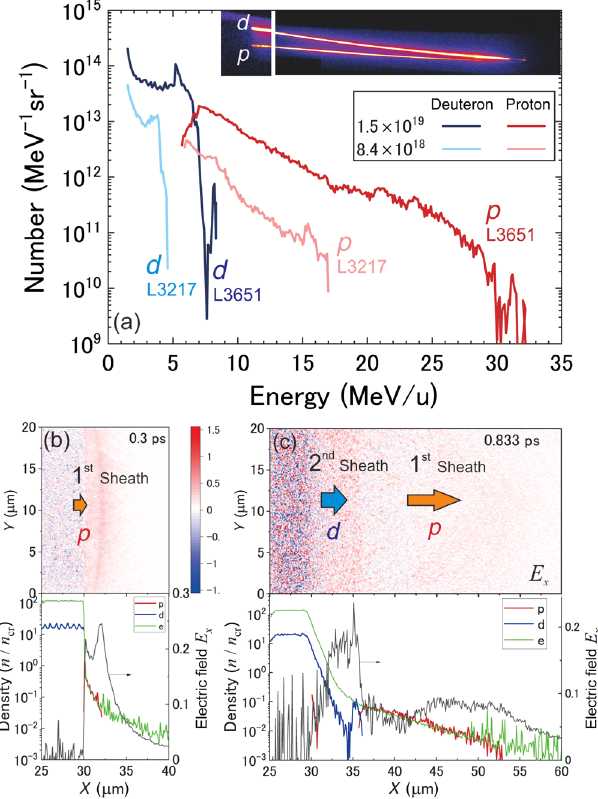
FIG. 1. (a) Energy distribution of protons ( p ) and deuterons ( d ) measured with the Thomson parabola ion spectrometer (TP) for two different laser intensities: 1 . 5 × 10 19 and 8 . 1 × 10 18 W cm − 2 . The laser shot number is also displayed. The inset shows the raw data of parabolic curves for the shot L3651. (b) and (c) Results of the 2D PIC simulation with the PICLS code [22], showing the electric fields induced on the rear side of the foil at 0.3 ps (b) and 0.833 ps (c) after the laser incidence. The initial position of the foil rear surface is at x ¼ 30 μ m, and the center axis of the laser is at y ¼ 10 μ m in the upper figures. The lower figures show the electric fields integrated over the y axis as the black line, together with the densities of protons, deuterons, and